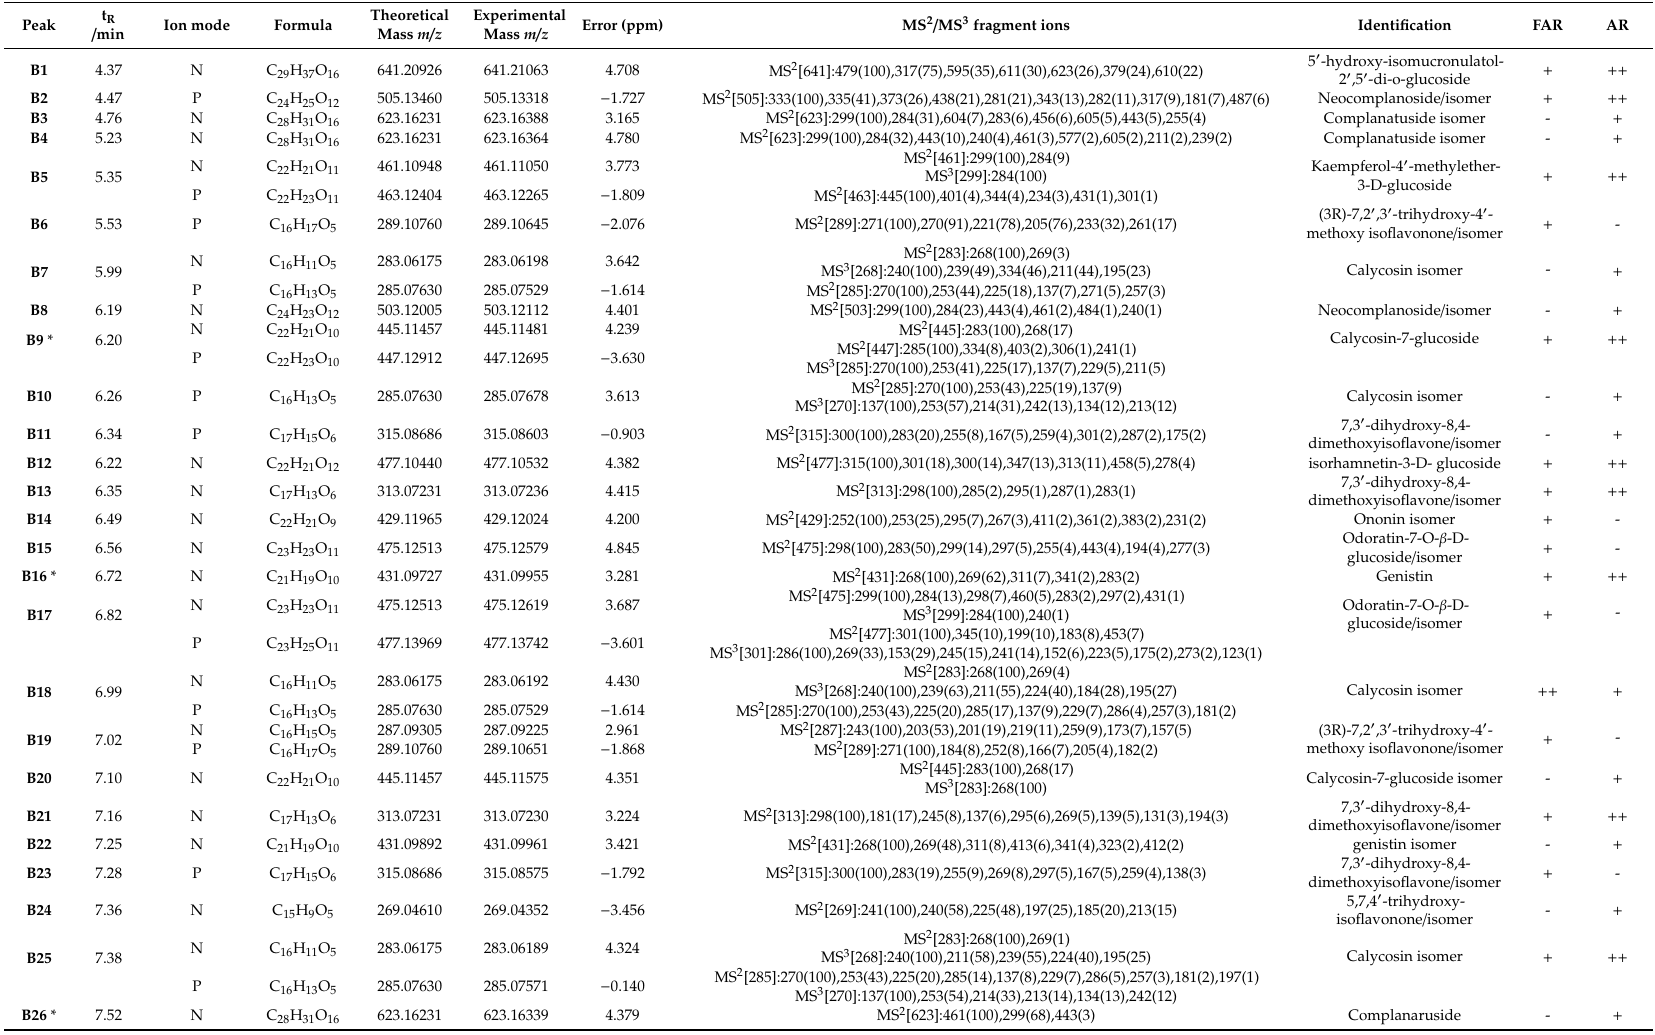
Table 2. Summary of identified flavonoids in AR and